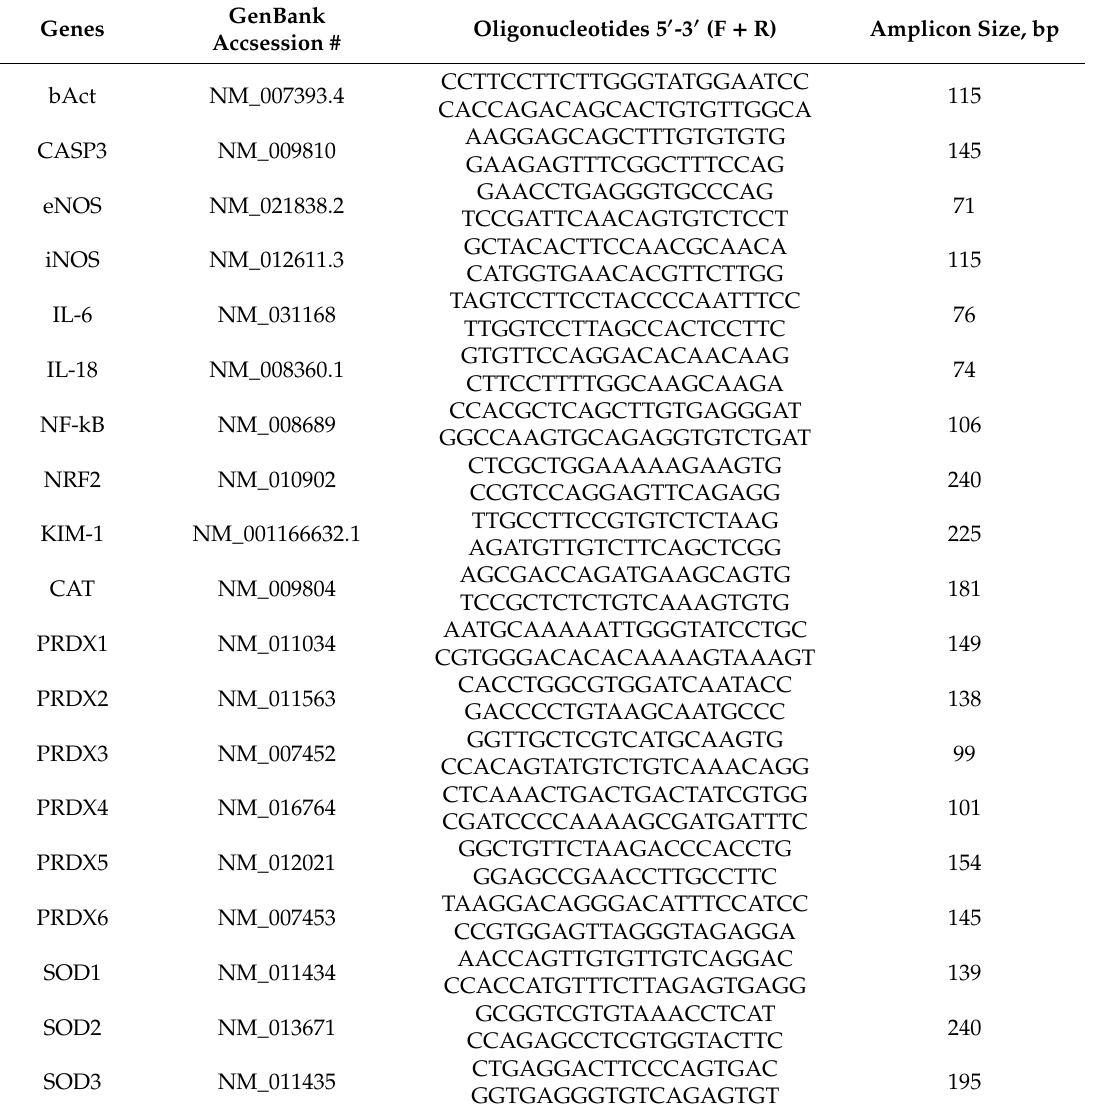
Table 1. Oligonucleotides used for real-time PCR. The design of oligonucleotides was carried out with the use of Primer-BLAST (www.ncbi.nlm.nih.gov). The calculated T m for all primers is 61–63 ◦